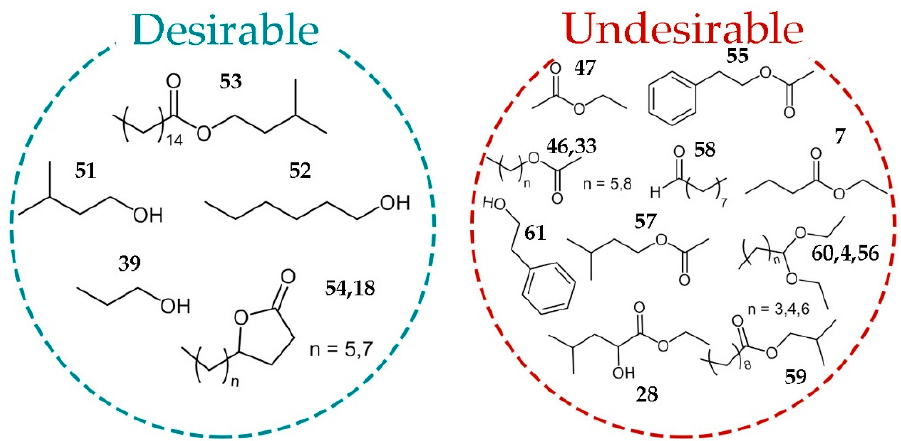
Figure 5. Desirable and undesirable metabolites as determined from correlation of brandies profiles with their sensory properties.